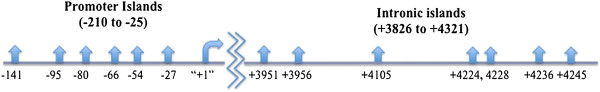
Diagrammatic representation of Foxp3 promoter and intronic regions [NM_014009: NCBI]. Vertical arrows indicate cytosine neighboring guanine (CpG) dinucleotide sequences that can be potentially methylated. The position of each CpG dinucleotide site is illustrated in relation to the transcription start, which is indicated as +1 bp (base pair).